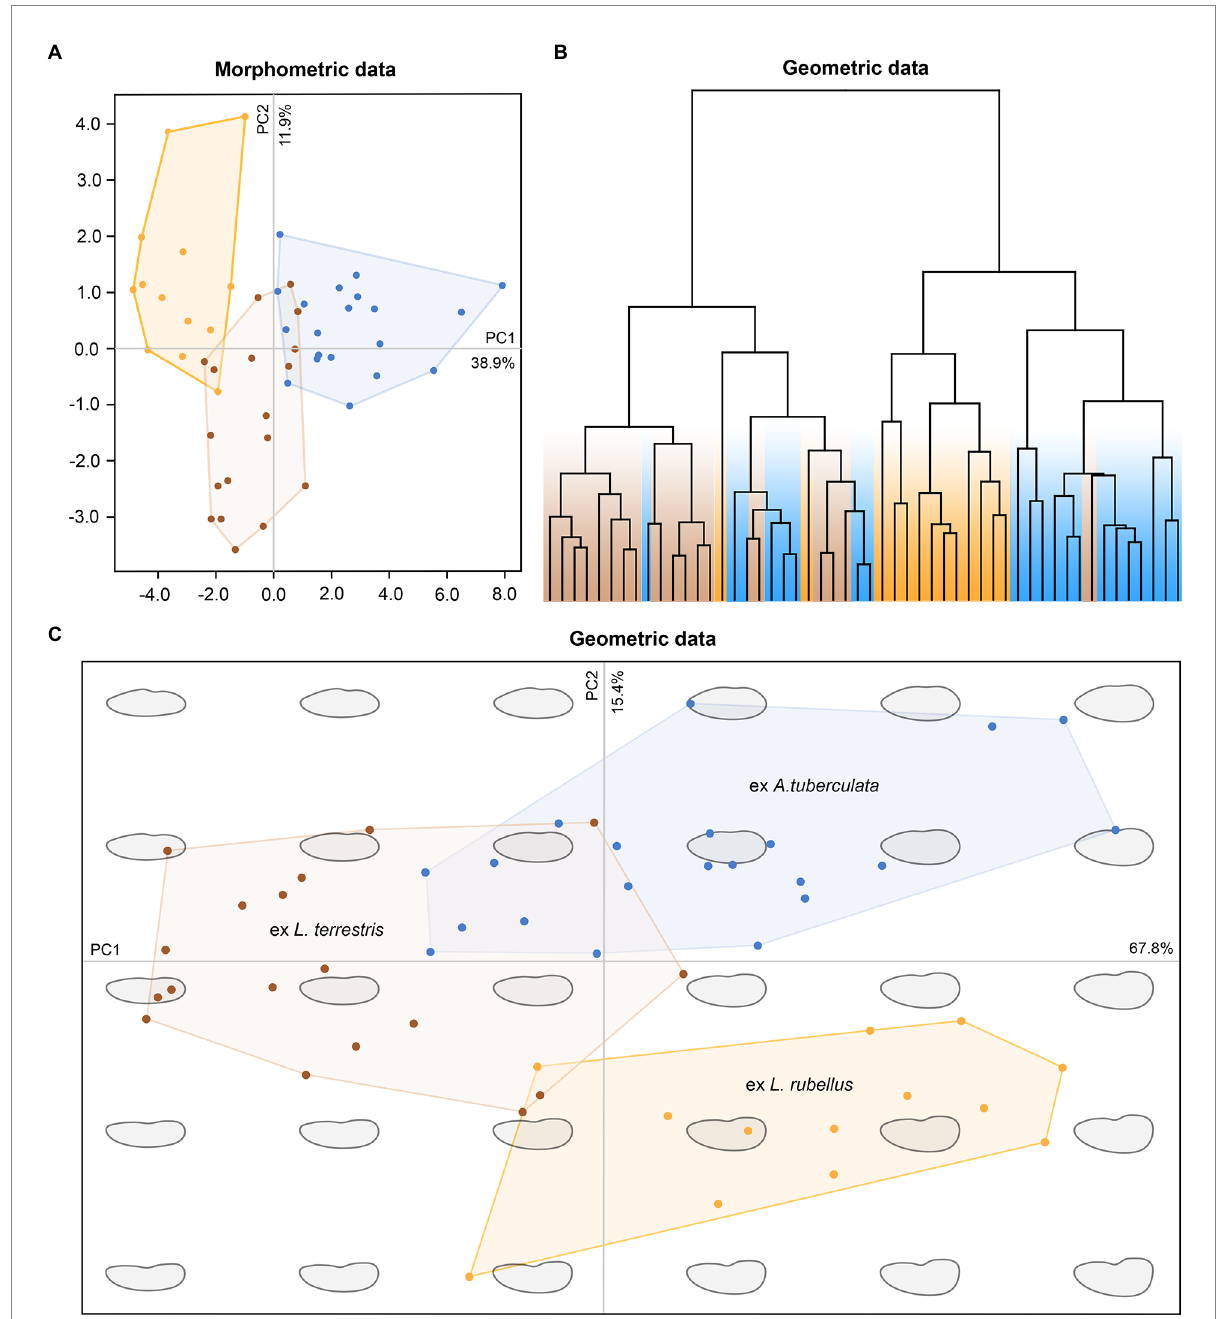
FIGURE 7 Multivariate statistical analyses of morphometric and geometric data of 52 protargol-impregnated specimens originated from epigeic (marked by yellow color), anecic (brown), and endogeic (blue) lumbricid earthworms. (A) Ordination diagram based on principal component analysis of 21 morphometric characters. (B) Cladogram based on geometric information and constructed using the complete linkage algorithm. (C) Ordination diagram based on principal component analysis of the Fourier coefficients derived from geometric